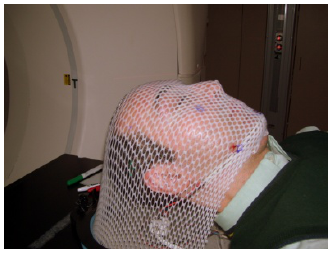
Figure 1. A typical setup to avoid head orientation change during radiotherapy using aquaplast thermoplastic (opti-mold) to provide pressure over the skin to immobilize head